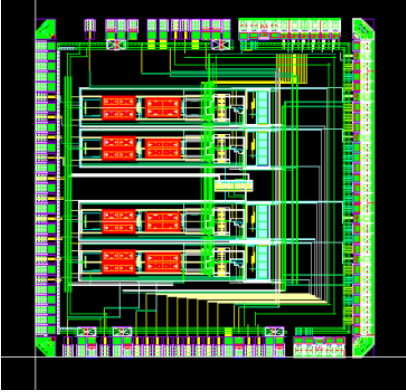
Figure 14. Four-channel FEE design